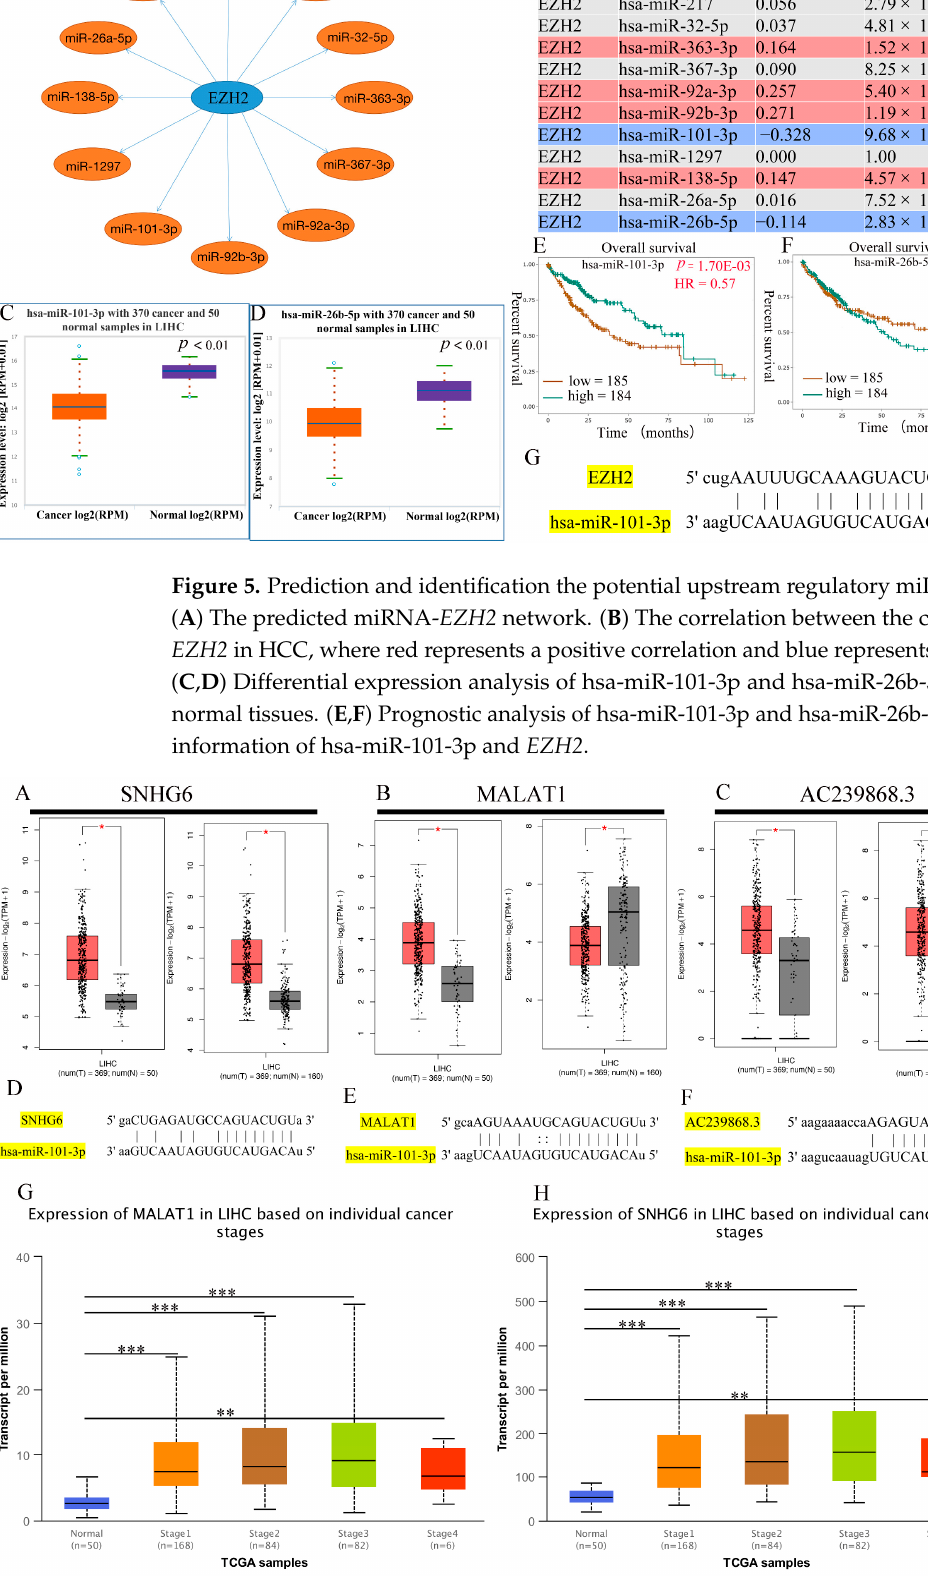
Figure 6. The differential expression level of upstream lncRNAs of hsa-miR-101-3p in